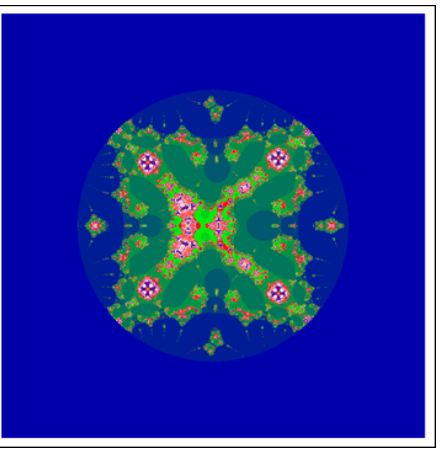
Figure 14. J-set via F-iteration sin ( z 4 ) + 0.55 with visualization time = 62.5